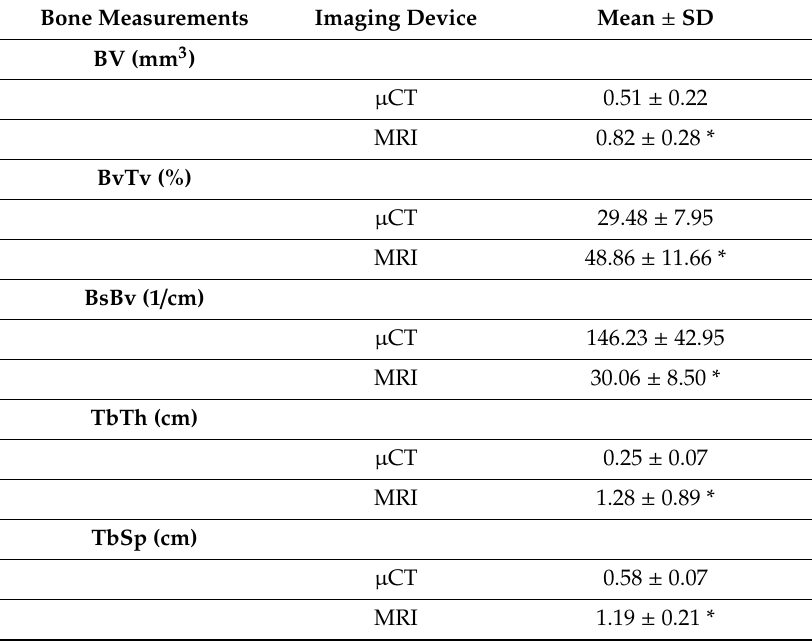
Table 2. Descriptive data of bone measurements acquired by microcomputed tomography ( µ CT) and magnetic-resonance imaging (MRI).